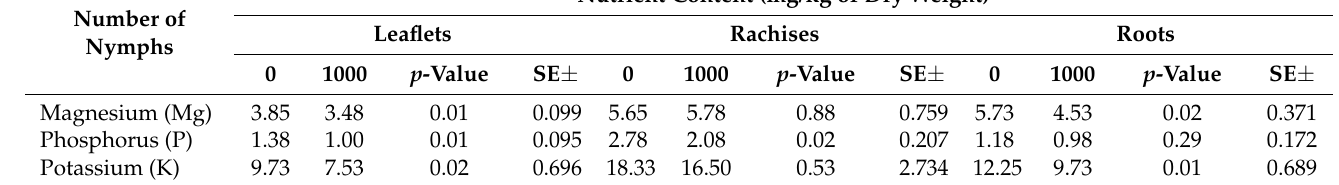
Table 2. Effect of infestation of 1000 O. lybicus per palm on nutrient concentration of leaflets, rachises and roots of date palm (cv. Khalas). Only significantly different ( p < 0.05) elements between treatments are shown.